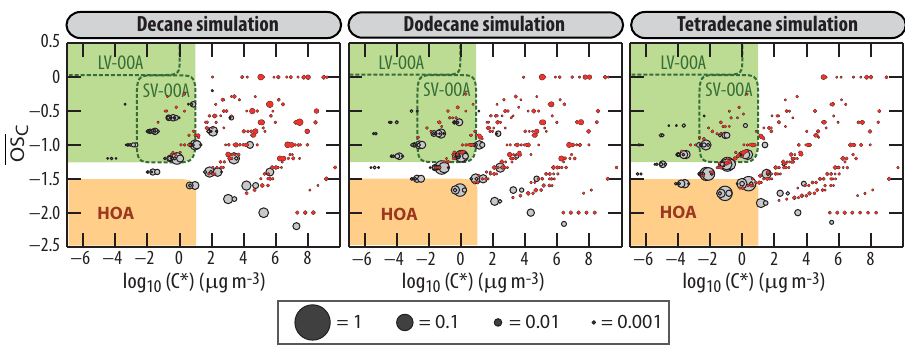
Fig. 7. Volatility and mean carbon oxidation state of the species produced during the oxidation of decane (1st column), dodecane (2nd column) and tetradecane (3rd column). Simulations are performed with C OA = 10µgm − 3 and the distributions are given for an aging time of 5days. See caption of Fig. 6 for the color code of the bubbles.